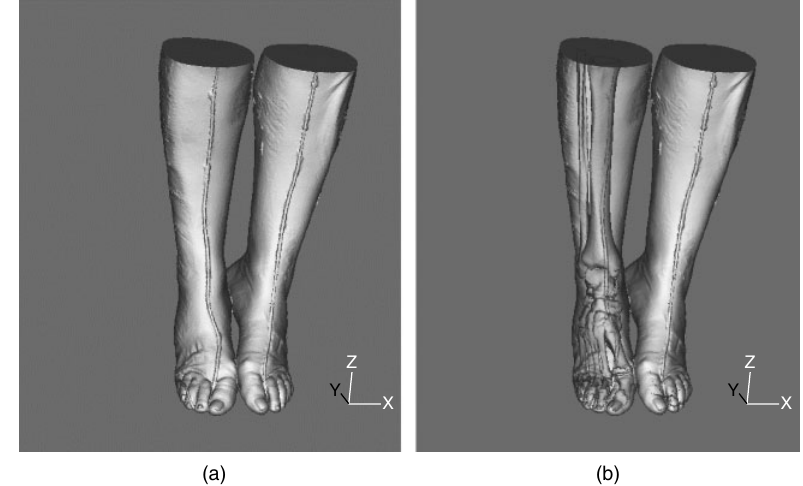
Figure 4 The 3D reconstructions of the Visible Human female: (a) the soft tissue model of both legs and (b) the soft tissue shown in conjunction with the skeleton of the right leg. No repair of the model was required. The models, once imported into 3D Studio R 3.1